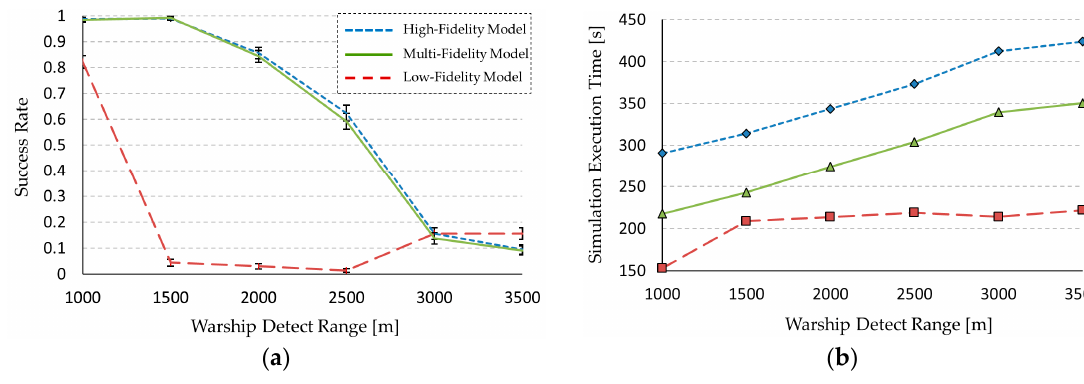
Figure 15. Simulation results for the UUV simulation: ( a ) UUV success rate against the warship detection range; ( b ) simulation execution time against the warship detection range.